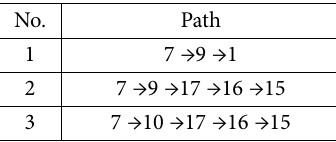
Table 7. A comprehensive list of paths (source: elaborated by the authors) No.